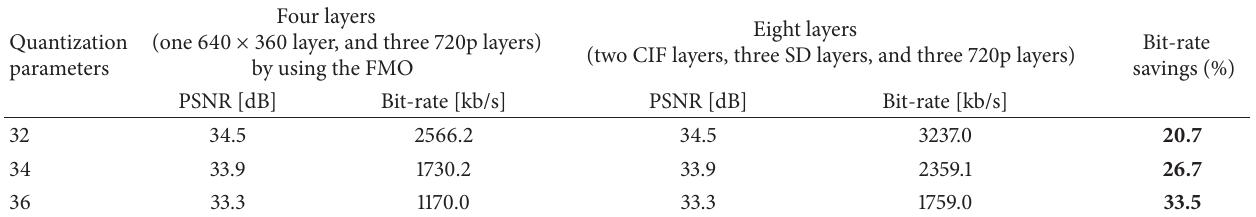
Table 5: FMO: four-layer coding versus eight-layer coding (“ STOCKHOLM ”, 30 fps, 96 frames, GOP size is 8). Quantization